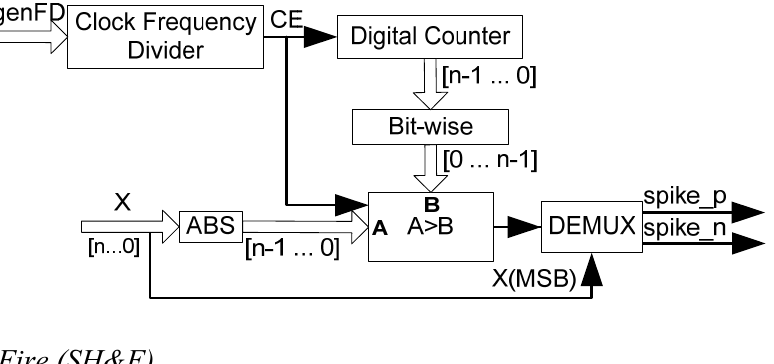
Figure 6. Reverse Bitwise Synthetic Spikes Generator internal